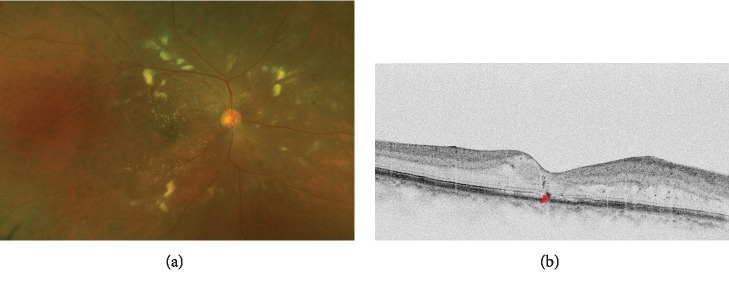
A representative patient who had diabetic macular edema with cotton-wool spots (CWS). (a) The baseline fundus photo image shows multiple CWS around fovea. (b) The baseline spectral domain-optical coherence tomography (SD-OCT) image shows focal ellipsoid zone disruption (red arrow).